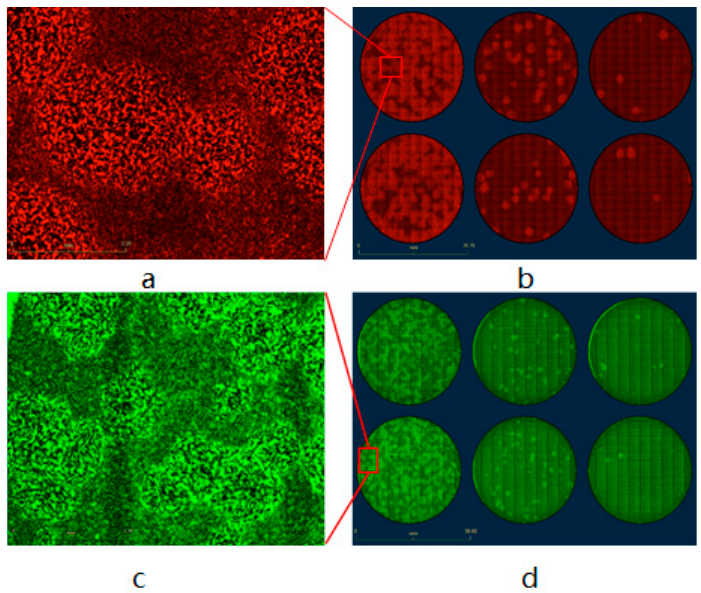
Figure 7. Vaccinia virus plaque assay based on fluorescent CV-1 cells ( a – d ). ( a ) IE from ( b ) A1 well, scale bar = 2.2 mm. ( b ) Recombinant vaccinia virus L1c-Ig-Turbo-infected wild-type CV-1 cells, scale bar = 37.7 mm. ( c ) IE from ( d ) B1 well, scale bar = 2.2 mm. ( d ) Recombinant vaccinia virus GLV-1h109-infected wild-type CV-1 cells, scale bar = 38.6 mm.